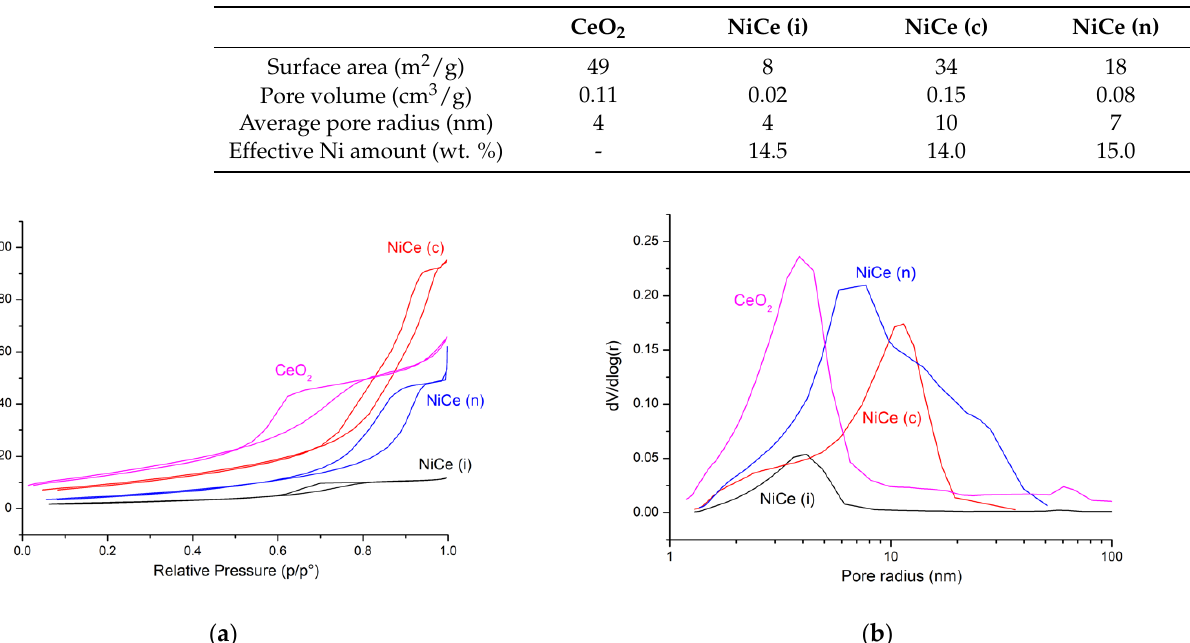
Figure 1. ( a ) N 2 physisorption isotherms of the three catalysts and support, ( b ) pore distribution of the three catalysts and support calculated using B.J.H. equation. the three catalysts and support calculated using B.J.H.